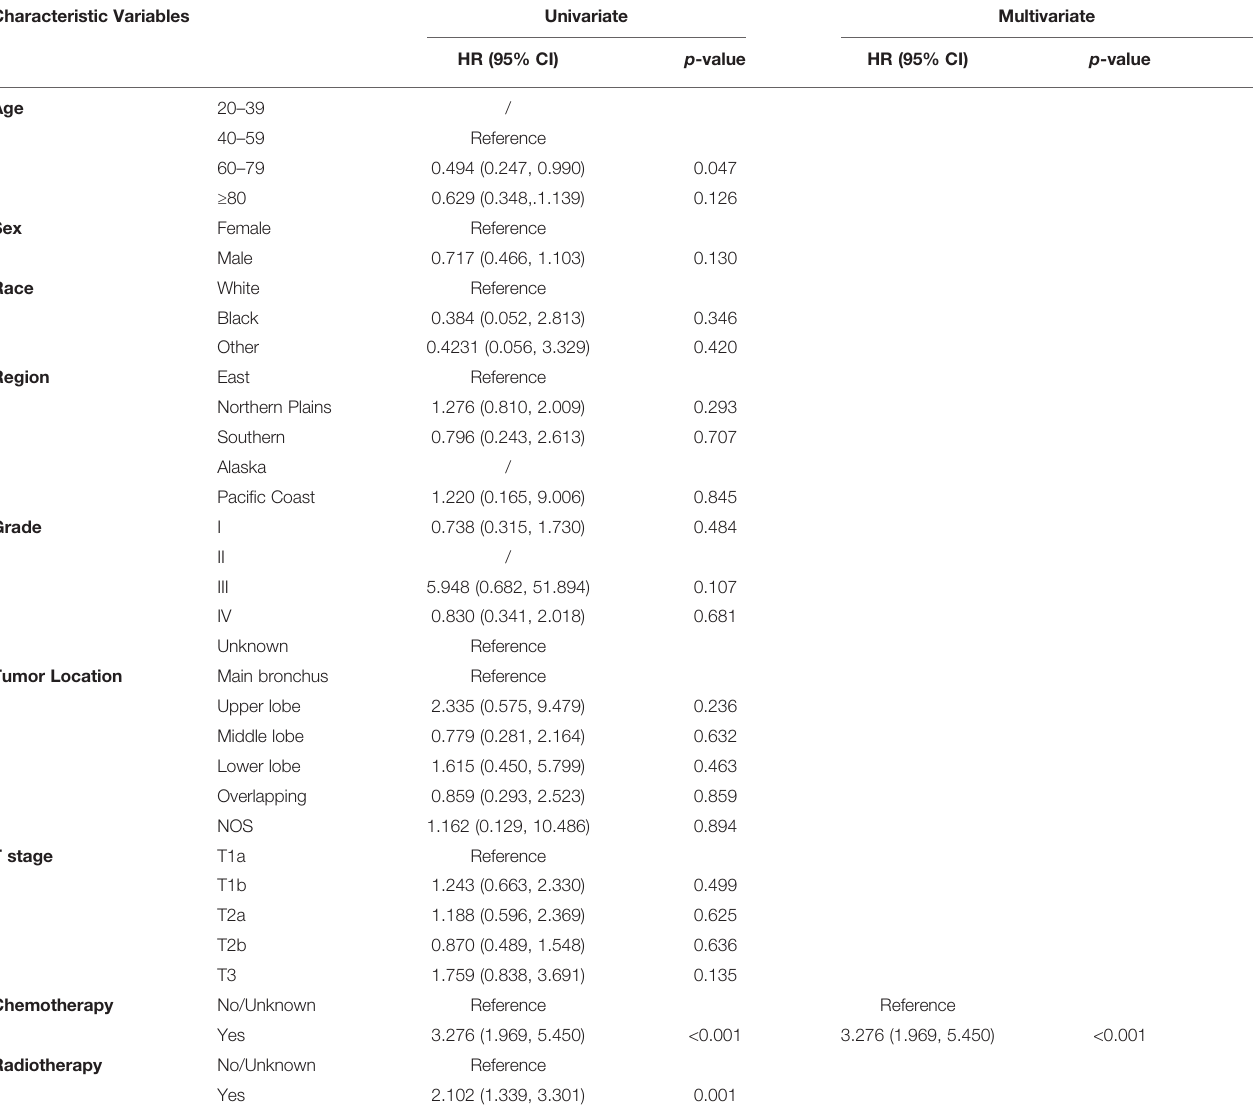
TABLE 3 | Univariate and multivariate analyses for OS in patients with unresectable IIIA-N2 LCNEC. Characteristic